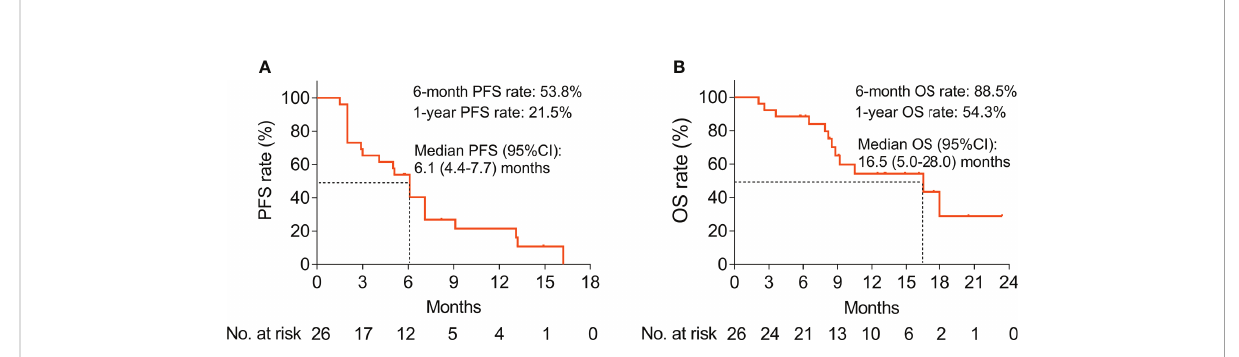
FIGURE 2 Survival pro fi le of BTC patients treated with ICIs plus CAPOX. Presentation of PFS (A) and OS (B) by Kaplan – Meier curves in BTC